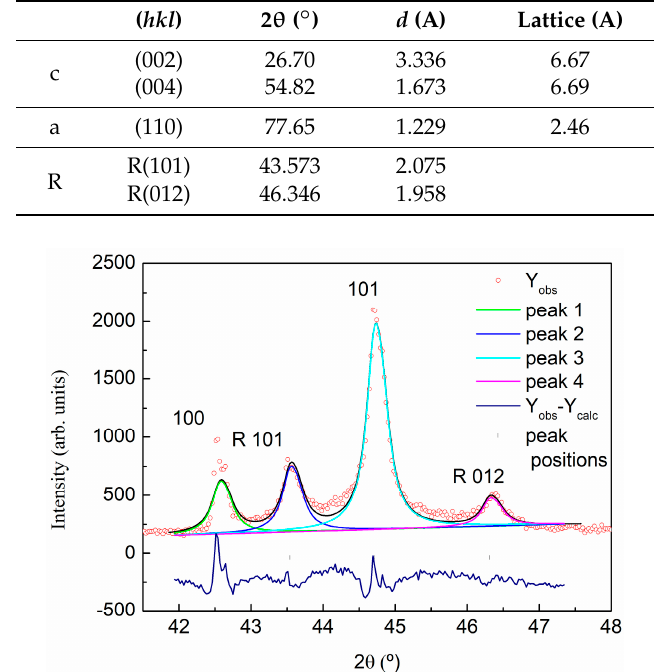
Figure 4. X-ray diffraction pattern of graphite. Profile refinement and the deconvolution of 41.5–47.5° 2 θ range of the pattern. Table 2. Measured interplanar spacings converted to lattice constants for graphite.